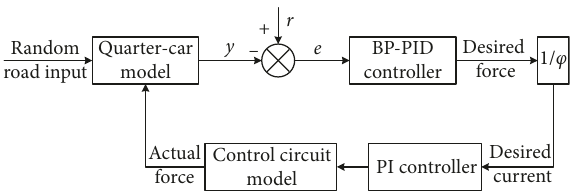
Figure 2: BP-PID control schematic of the EERAS system.